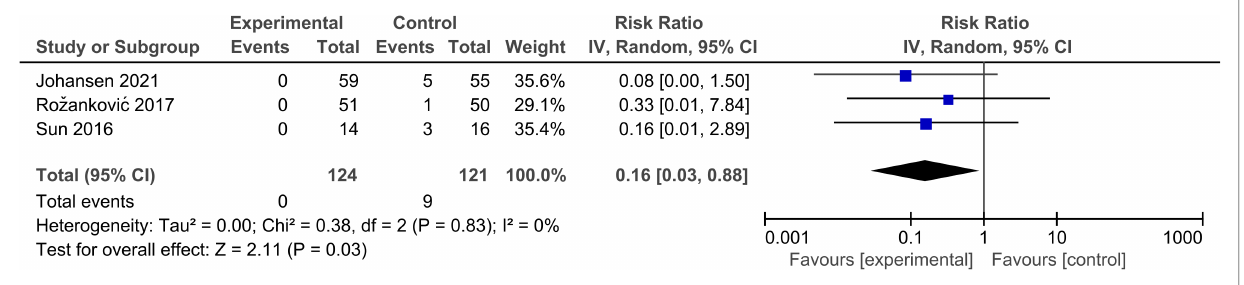
FIGURE 9 Comparison of ASD between the discover cervical disc arthroplasty (DCDA, “ experimental ” ) group and the anterior cervical discectomy and fusion (ACDF, “ control ” )